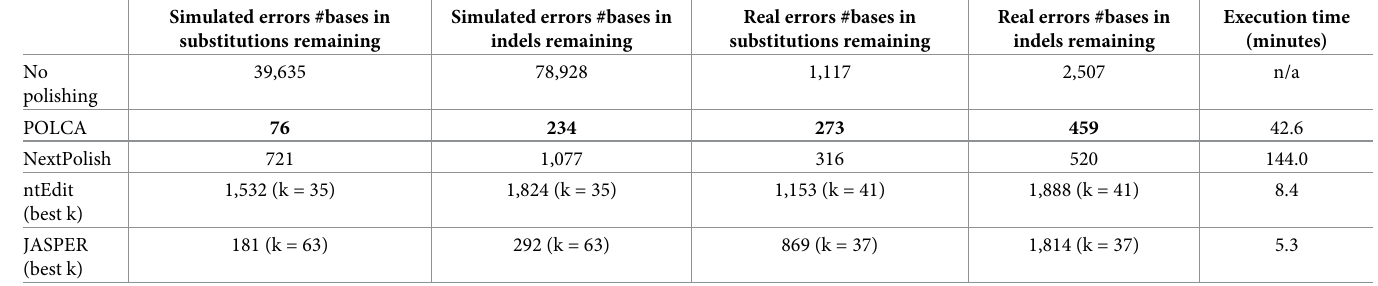
Table 1. Comparison of polishing tools on assemblies of A . thaliana . Numbers correspond to the number of bases in substitutions, insertions, or deletions detected by aligning the reads to the assemblies and calling variants with the freebayes software. Any variant with reference allele frequency 0 and alternative allele frequency > 1 was considered an error. For substitution errors we counted the number of bases in substitutions, and for indel errors we counted the number of inserted or deleted bases. Col- umns labeled “Simulated” refer to experiments where we introduced random errors into a reference, and that used short reads simulated from the unaltered reference for polishing. Columns labeled “Real” refer to experiments that used real Illumina reads to polish a draft assembly of the data. Timing data used a 24-core Intel Xeon Gold 6248R @ 3.0Ghz server with 24 threads. Execution time is given for the real data. The best value in each column (lower is better) is shown in bold.